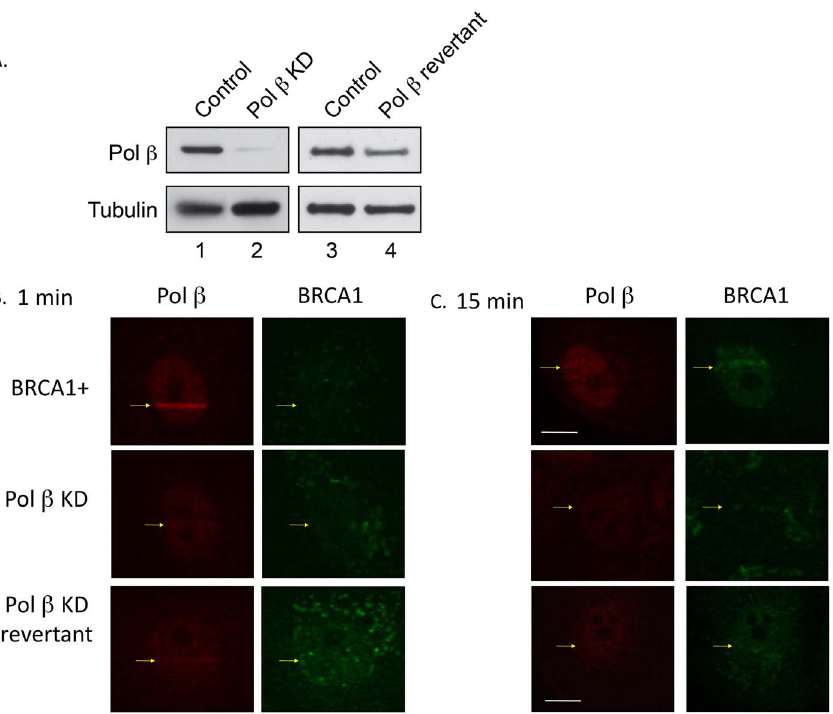
Figure 6. Analysis of pol b KD cells. A. Western blotting analysis of pol b in a pol b knockdown (KD) cell line and in a partial revertant. B and C. Immunofluorescence imaging of the recruitment of pol b and BRCA1 at 1 and 15 min after irradiation of BRCA1 + , pol b KD and pol b KD revertant cell lines. Bars represent 10 m m.